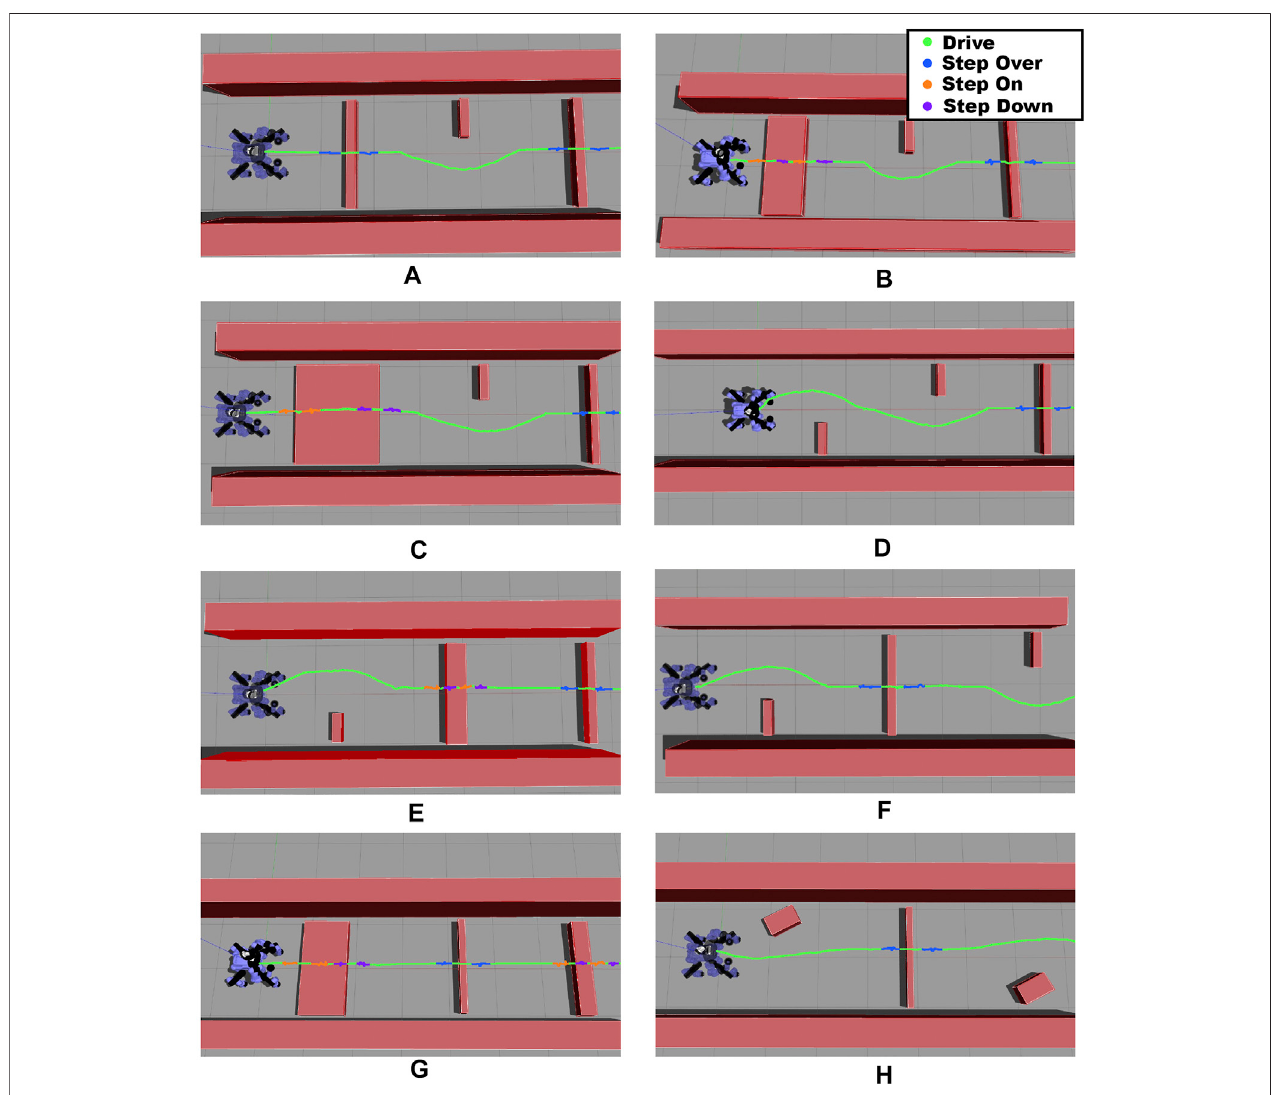
FIGURE11| Scenariosconsidered insimulationtochecktherobustnessoftheimplemented framework.Thecoloredlinerepresentsthetrajectoryfollowedbythe pelvis during the overall task and it is mapped as follows: green for driving, blue for stepping over, orange for stepping on and purple for stepping down.